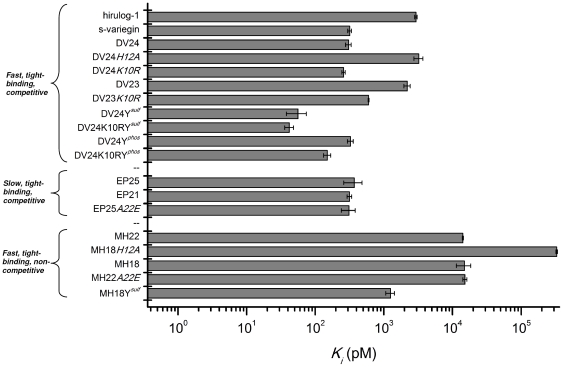

Ki values of all peptides (including hirulog-1/bivalirudin).Peptides are grouped according to their mechanism of actions. All competitive inhibitors (fast or slow) have higher affinities to thrombin compared to hirulog-1/bivalirudin. The most potent variant DV24K10RYsulf is about 70-fold stronger. Even their cleavage products (non-competitive inhibitors) are potent inhibitor, with one of them, MH18Ysulf, binds to thrombin approximately 2-fold tighter than hirulog-1/bivalirudin.